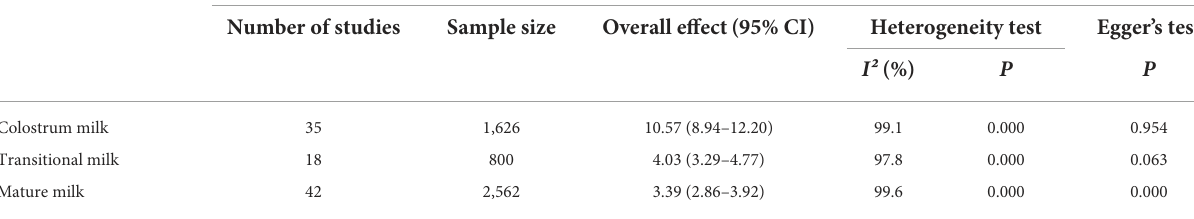
TABLE 3 Meta-analysis